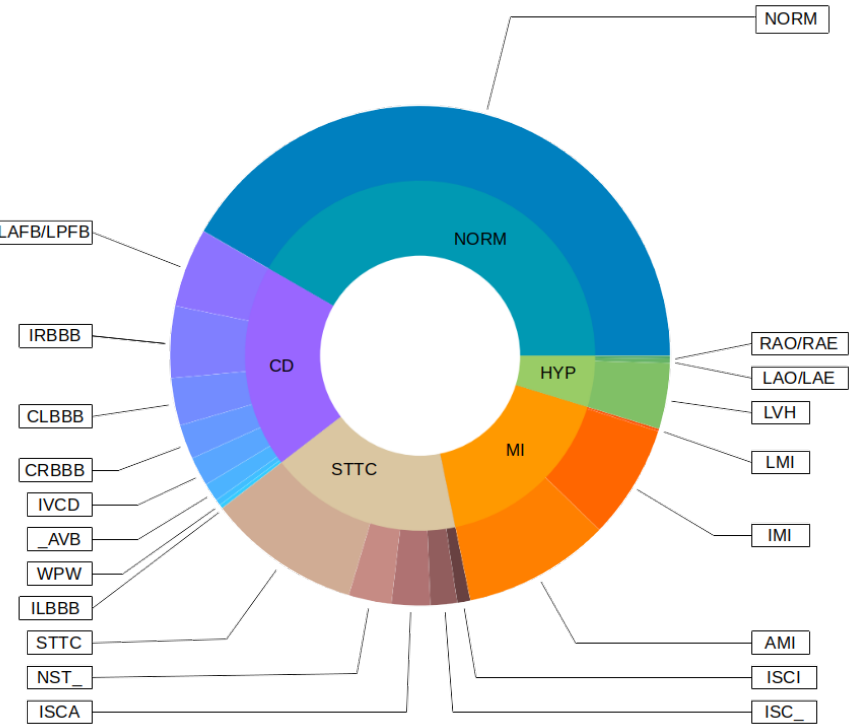
Figure 3. Classes and subclasses of used